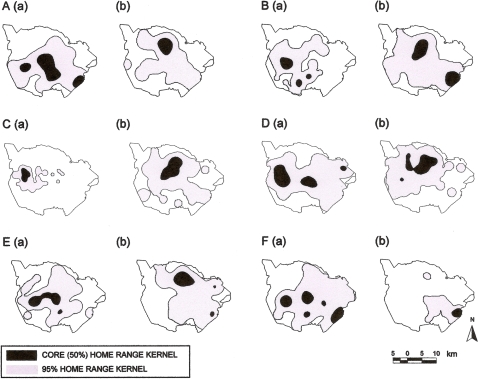
Behavioural response to fire showing core home range and 95% home range kernels for:uninjured adult cows (A) CE13, (B) CE81, (C) CE61, (D) CE32 and injured adult cows (E) CE88 and (F) CE03 three months (a) before and (b) after injury in a fire on 21 September 2005 in Pilanesberg National Park. The percentage overlap between 95% home ranges before and after the fire was: (A) 80.5, (B) 72.7, (C) 49.7, (D) 86.0, (E) 74.1 and (F) 52.5 respectively.